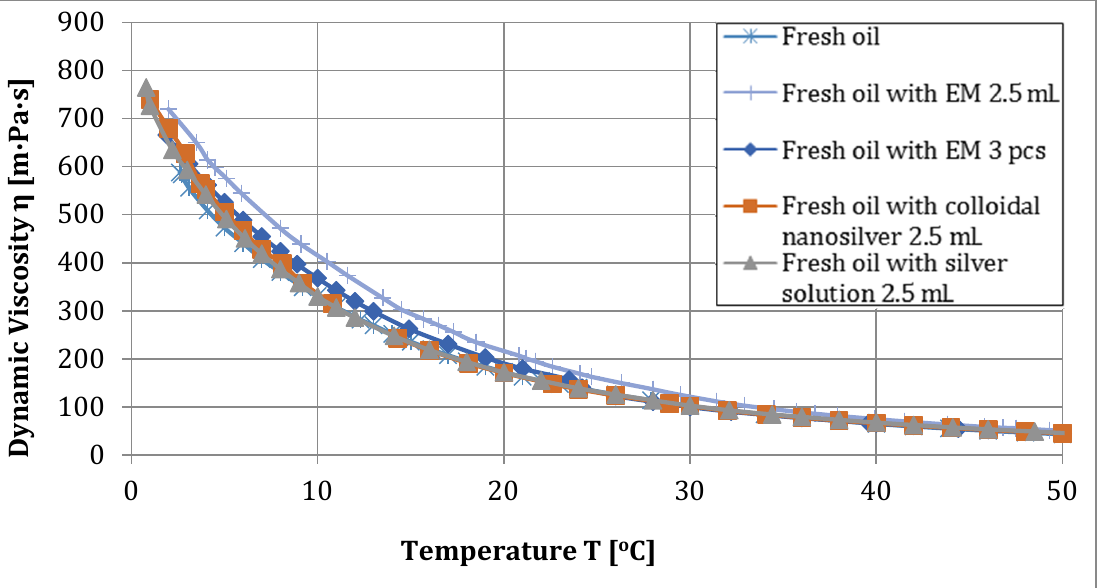
Figure 7. Flash point for oil with effective microorganisms (EM), colloidal nanosilver (CN), and silver solution (SS).